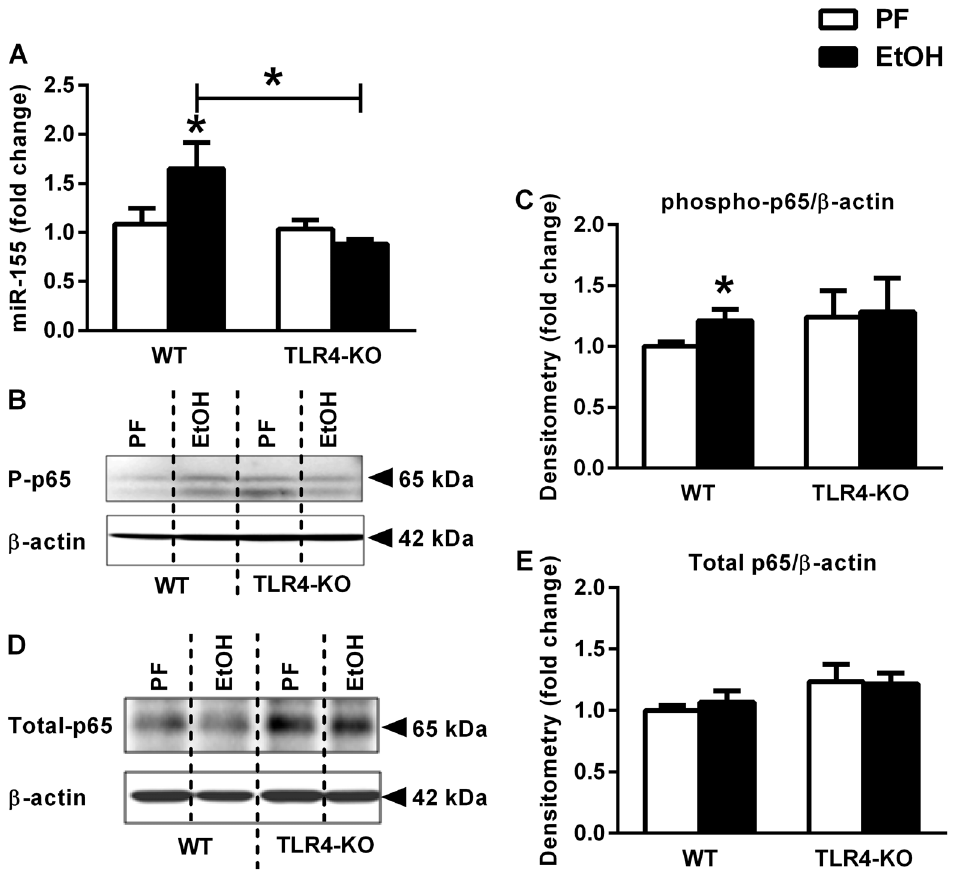
Figure 5. Induction of microRNA-155 is TLR4 dependent in alcohol-fed mouse cerebellum. WT (n=8 or 7) and TLR4-KO (n=8 or 13) mice were fed with control (PF) or EtOH diet for 5 weeks, respectively. MiR-155 (A) was assessed by real-time PCR from whole cerebellar miRNA extract, corrected with snoRNA202. Phosphorylated-p65 (B–C) and total-p65 (D–E) protein of whole cerebellar lysates was assessed by Western blot, using b - actin as loading control, and further quantified by densitometry which represents six to twelve samples per group. Bars represent mean 6 SEM (*: p value , 0.05 relative to appropriate PF or WT controls, by Kruskal-Wallis non-parametric test).